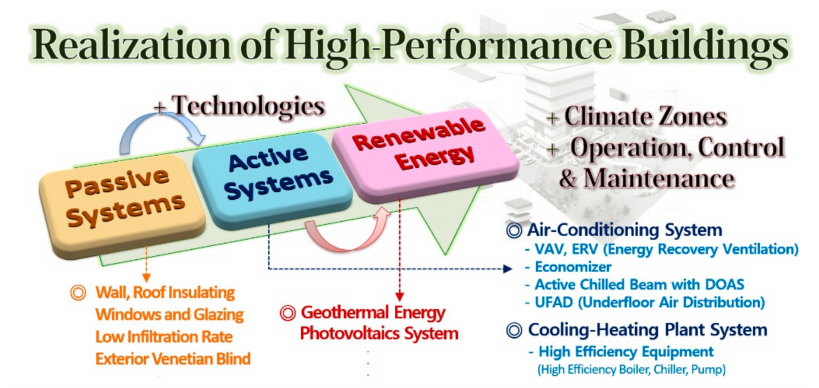
Figure 2. Method for the realization of high-performance